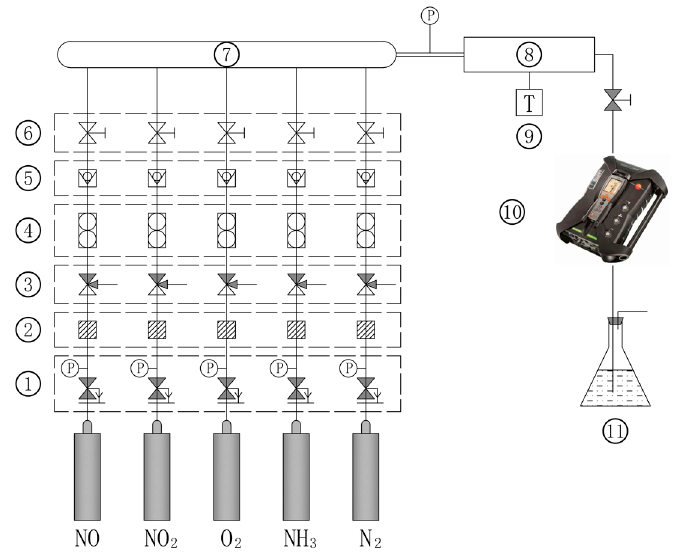
Figure 1. Experimental system of activated carbon denitration. 1. Pressure reducing valve 2. Filter 3. Three-way valve 4. Mass flow controller 5. Check valve 6. Stop valve 7. Mixing chamber 8. Tubular